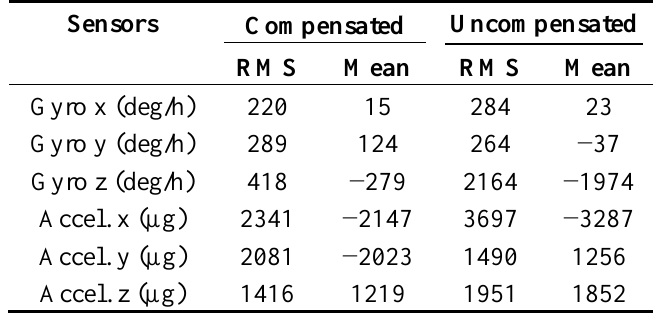
Table 10. Statistical results of MTi-G output errors with and without compensation.